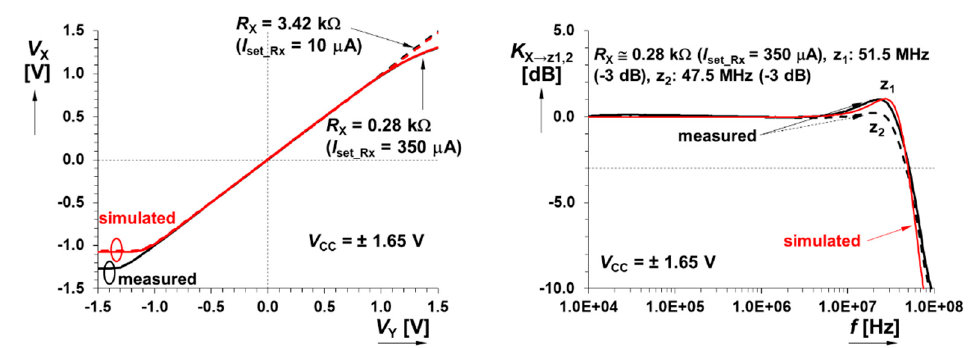
Figure 9. Selected results of the measured and simulated responses of the CCCII: (left) DC response of the Y → X transfer; (right) AC responses of X → z 1–2 transfers.